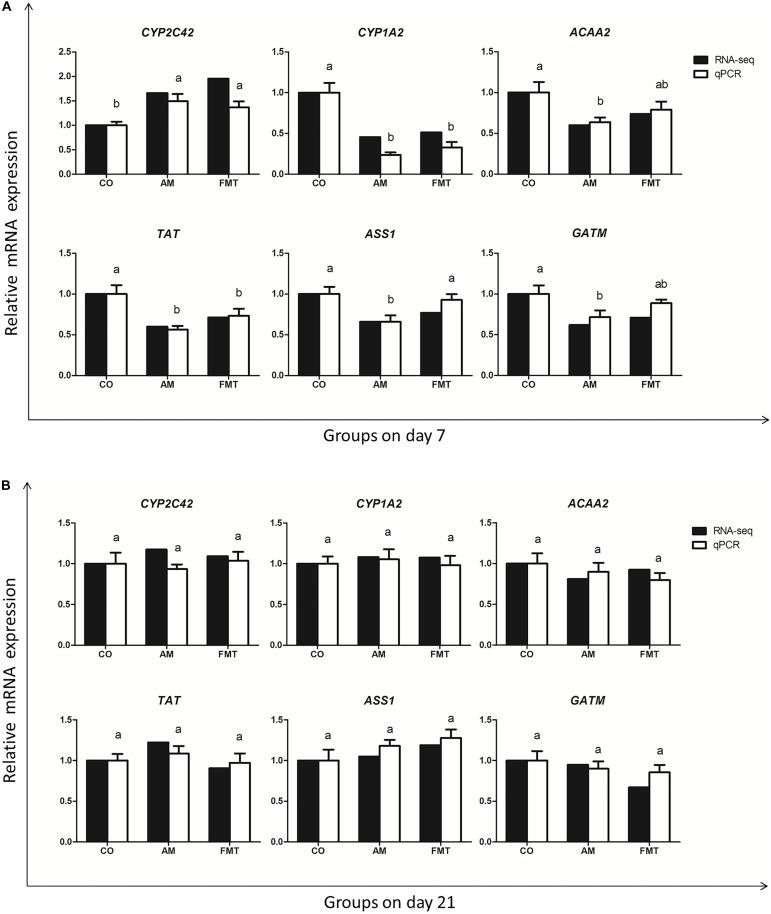
The qPCR validation of the RNA-seq. The results are displayed as the values of fold changes in the CO group on day 7 (A) and day 21 (B), and the qPCR data are presented as the means ± SEM (n = 5). Values with different lowercase letter superscripts indicate a significant difference (P < 0.05), and those with the same letter superscripts indicate no significant difference (P > 0.05). CO: control; AM: amoxicillin; FMT: fecal microbiota transplantation. CYP2C42: cytochrome P450 C42; CYP1A2: cytochrome P450 family 1 subfamily A member 2; ACAA2: acetyl-CoA acyltransferase 2; TAT: tyrosine aminotransferase; ASS1: argininosuccinate synthase 1; GATM: glycine amidinotransferase.